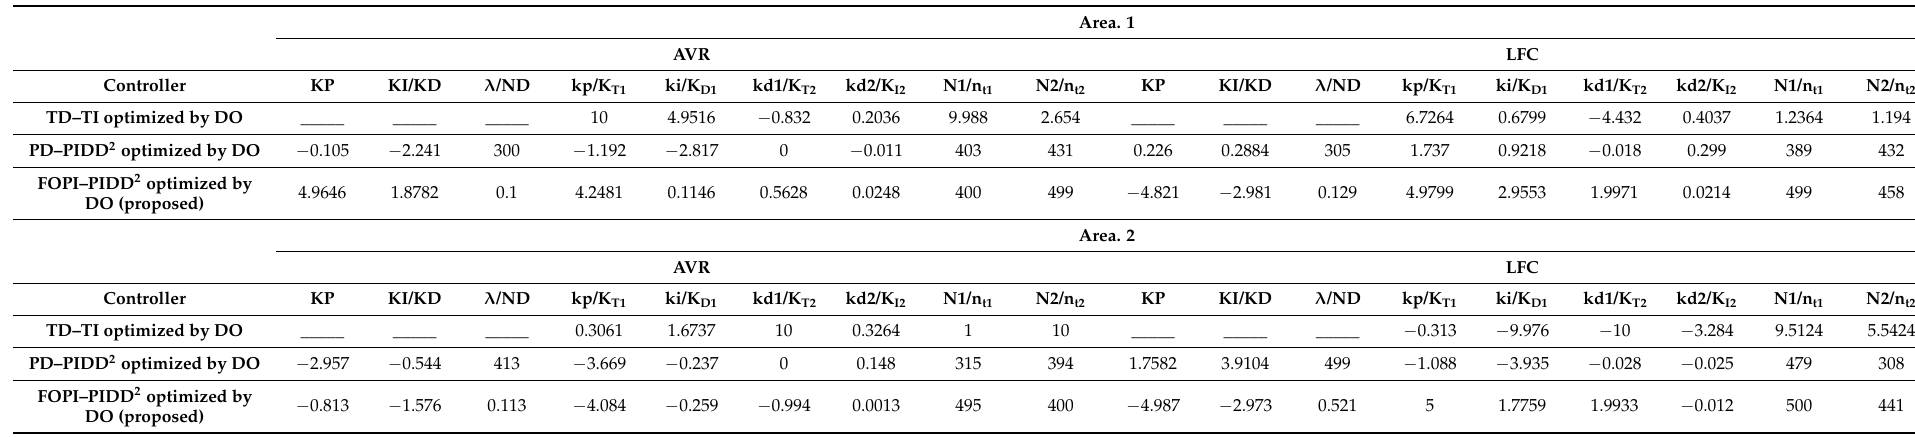
Table 2. Optimal parameters of the three controllers for scenario 1.